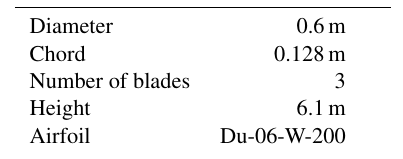
Table 1. Mariah Windspire 1.2kW VAWT parameters.